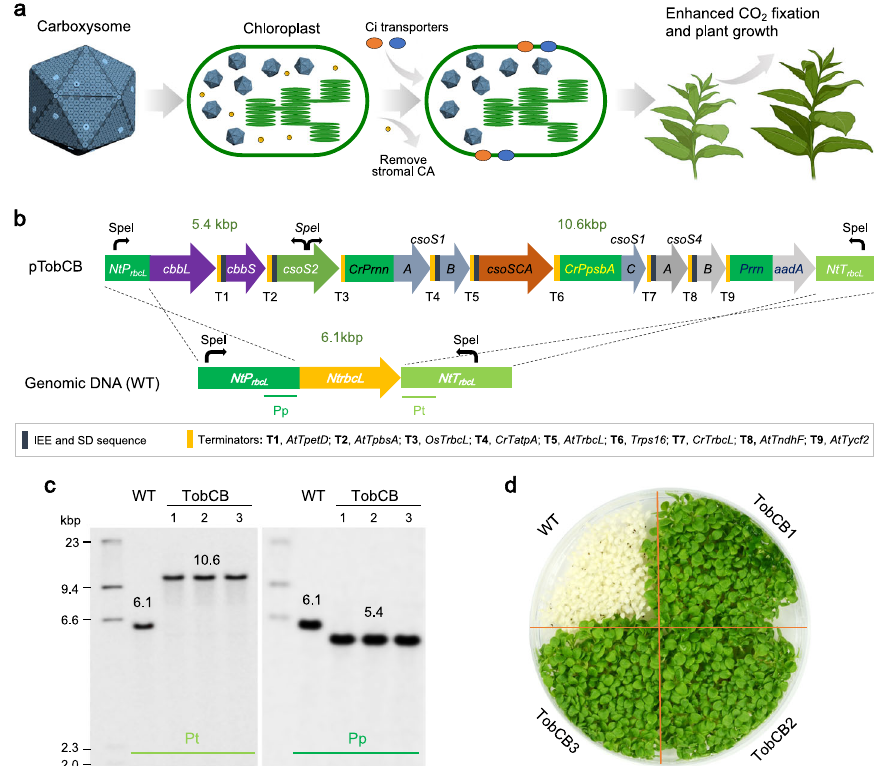
Fig. 1 | Synthetic engineering of α -carboxysomes into tobacco chloroplasts. a Schematic representation of the strategies of introducing carboxysomes and bicarbonate transporters into plant chloroplasts and eliminating chloroplastic CA